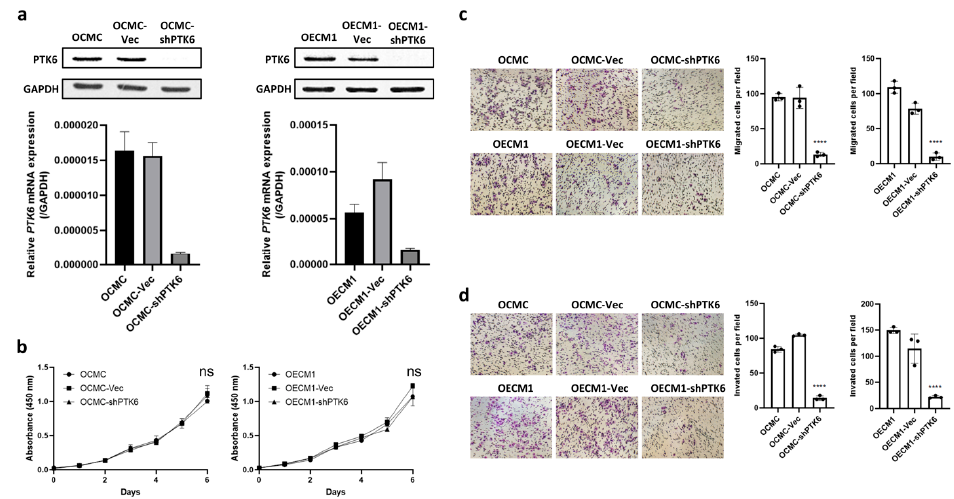
Figure 3. Downregulation of PTK6 suppressed OSCC cell migration and invasion. ( a ) OCMC and OECM1 cell lines were used to knock down PTK6 by using shRNA. The mRNA and protein expression were examined through real-time PCR and Western blotting in PTK6 knockdown cells. ( b ) Cell viability of control and PTK6 knockdown cells was evaluated using a WST-1 assay. Absorbance was measured at 450 nm at seven time points (0, 24, 48, 72, 96, 120, and 144 h) to calculate the proliferation rate. ( c ) The migration abilities of control and PTK6 knockdown cells were examined using a transwell assay. Migrated cells were quantified using ImageJ. (d) The invasive abilities of control and PTK6 knockdown cells were measured using a transwell Matrigel assay. Invasive cells were quantified using ImageJ. ns means not significant. **** p < 0.001.